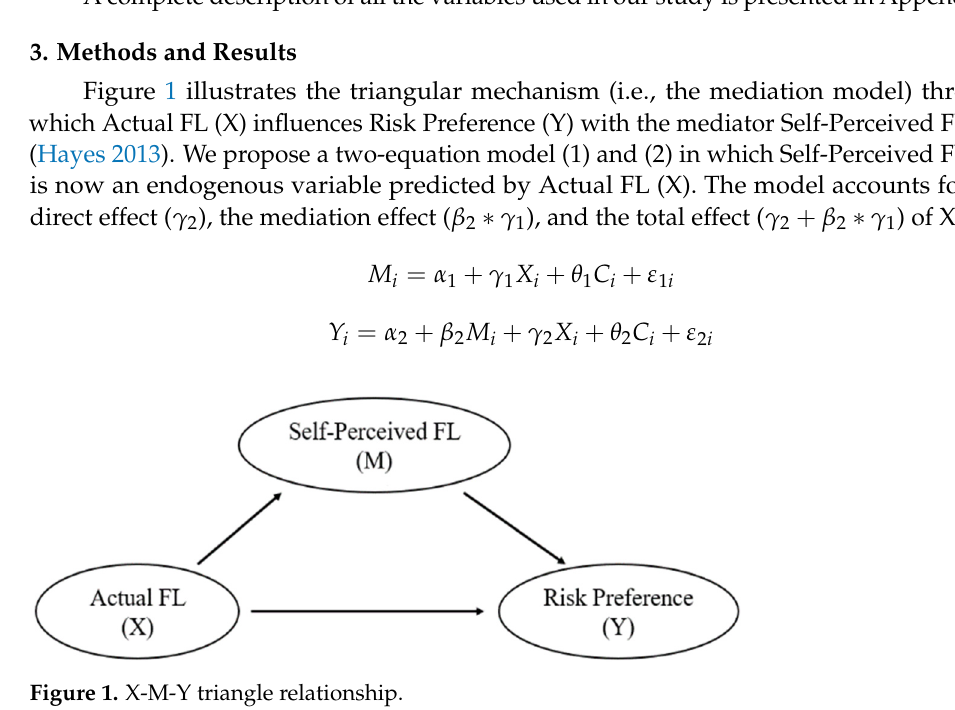
Table 1. Summary statistics of key variables.